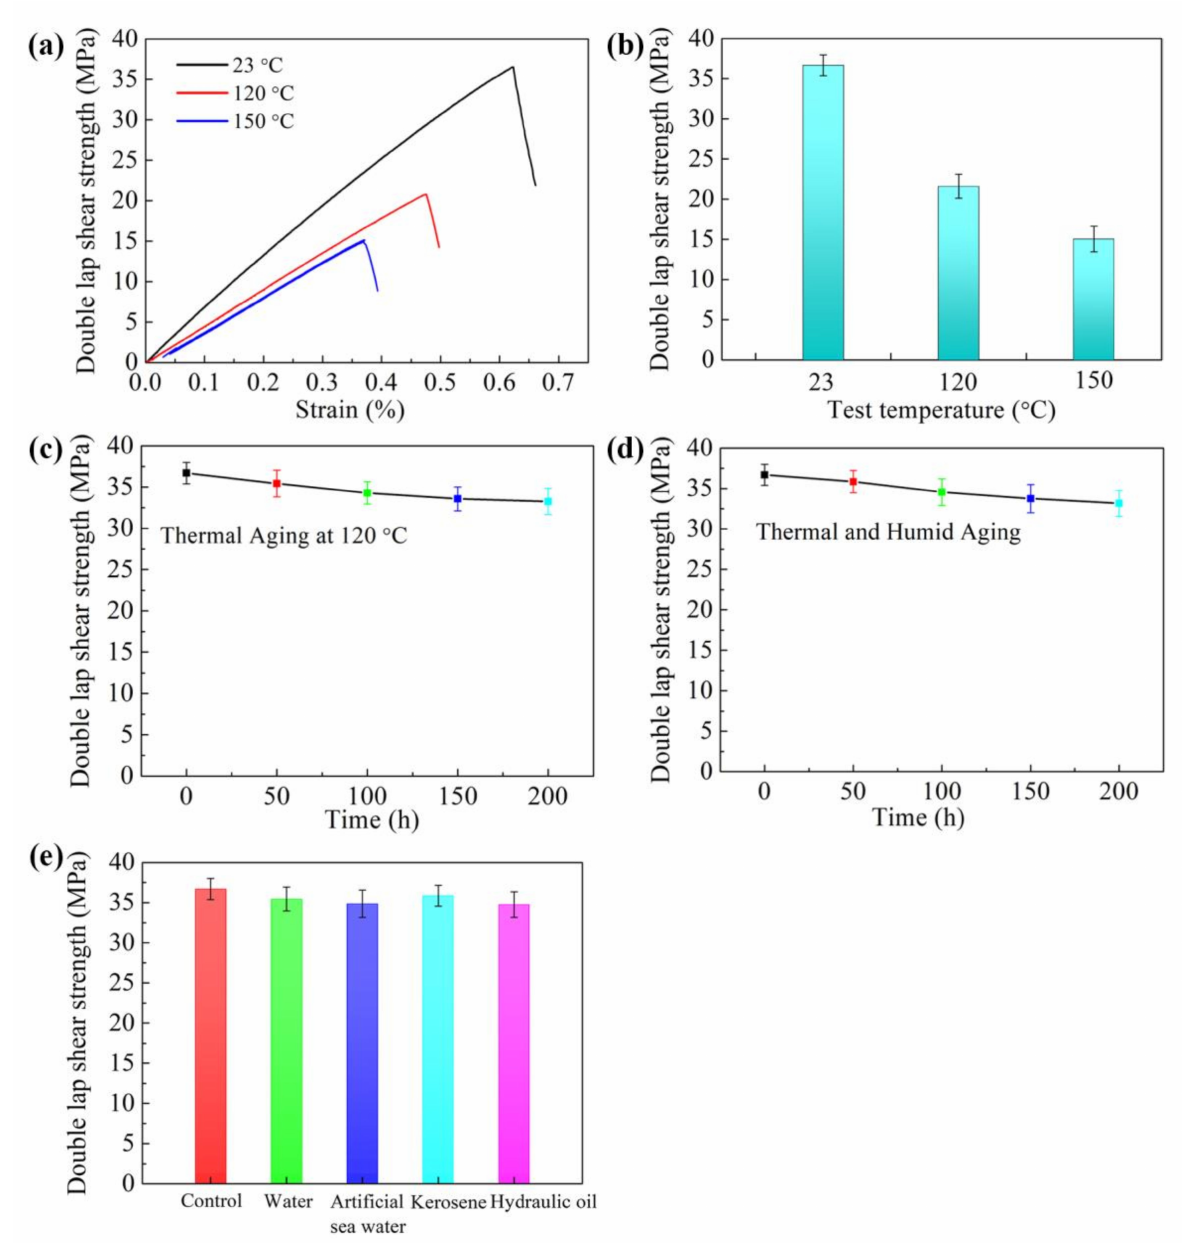
Figure 8. Durability performance of Ep/PHO30/nBN30 structural film adhesive: ( a ) stress–strain curves at different temperatures, ( b ) shear strength at different test temperatures, ( c ) shear strength after thermal aging at 120 ◦ C, ( d ) shear strength after thermal and humid aging (71 ◦ C, 95% relative humidity), and ( e ) medium resistance performance (immersed in medium for 7